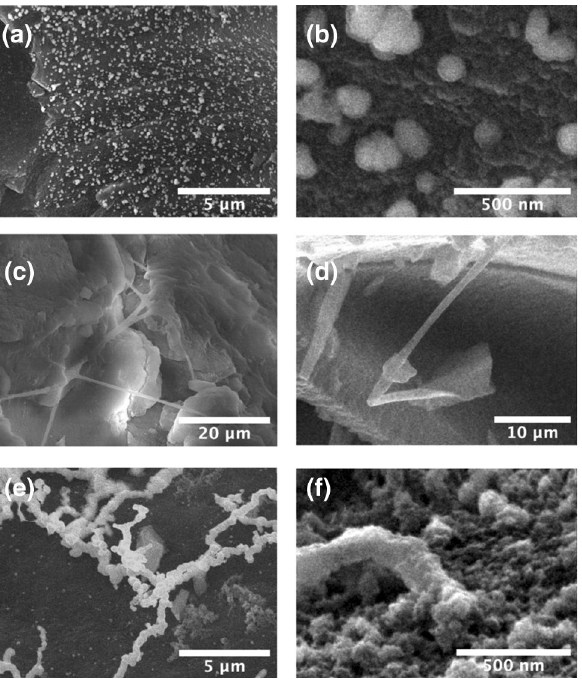
Figure 6. SEM images of nickel-silica aerogel synthesised with different concentrations of sodium hydroxide: ( a , b ) 0.5 M NaOH, ( c , d ) 1 M NaOH, ( e , f ) 2 M